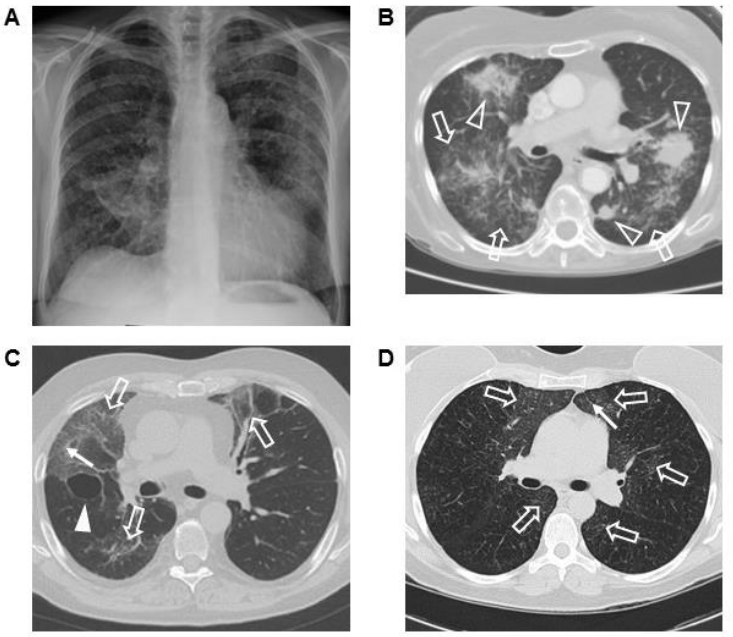
Figure 2. Posteroanterior chest radiograph ( A ) and representative computer tomography (CT) scan of the chest image ( B ) from a patient with Erdheim–Chester disease (ECD) and severe interstitial lung disease (ILD). Multiple bilateral consolidated masses (open arrowheads) with ground-glass infiltrates (open arrow) are found ( B ). Ground-glass infiltrates, reticulations (arrow), and a right lung cyst (solid arrowhead) are shown in another patient with ECD and severe ILD ( C ). Diffuse ground-glass opacification and reticulations are demonstrated in a third patient ( D